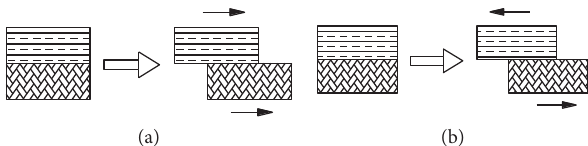
Figure 7: Types of strata dislocation. (a) Same direction dislocation. (b) Isokinetic dislocation.